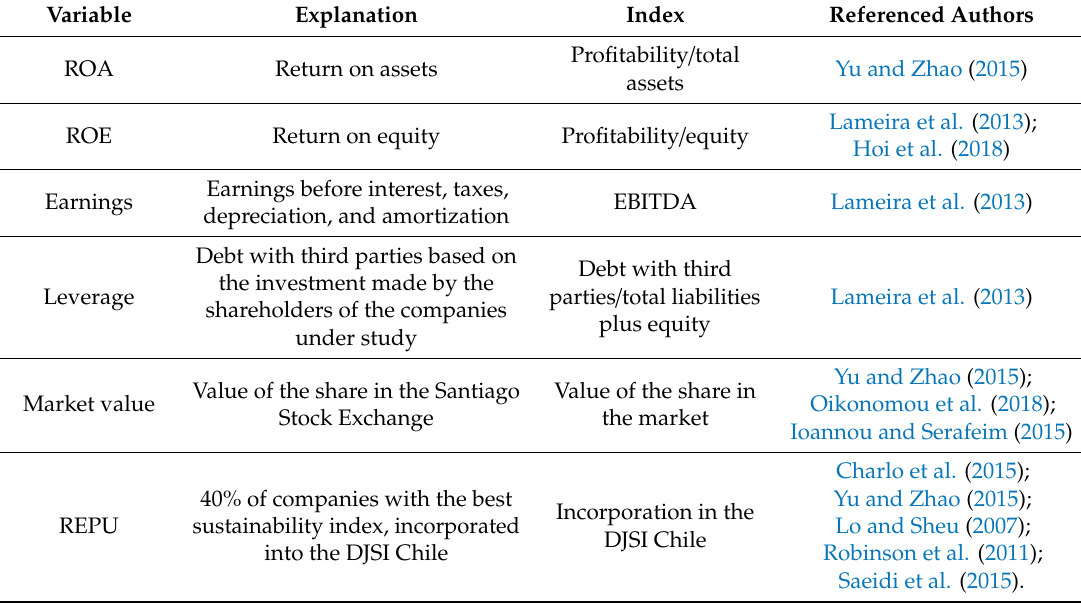
Table A1. Variables incorporated in this research according to the